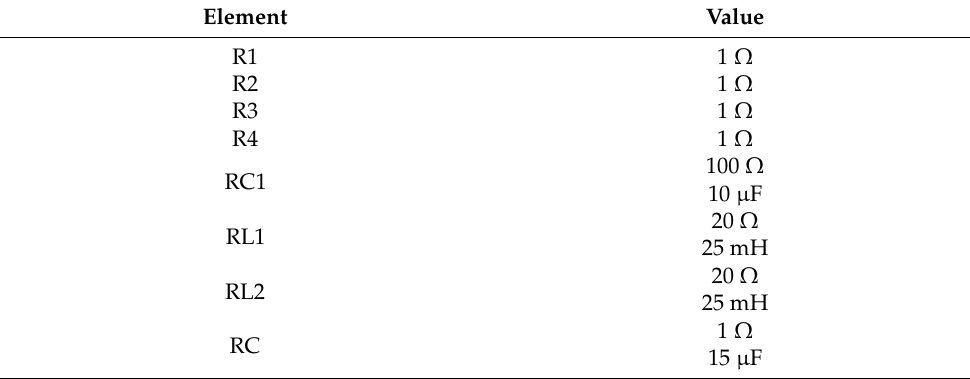
Table 3. Values of elements of the coupling/decoupling